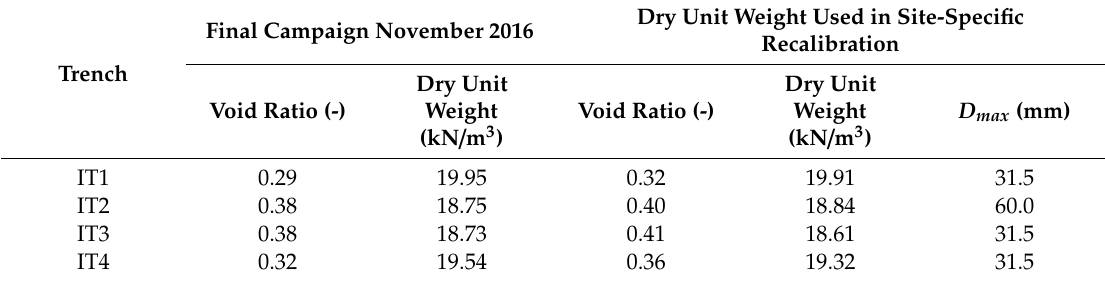
Table 4. Dry unit weight calculated from in-situ